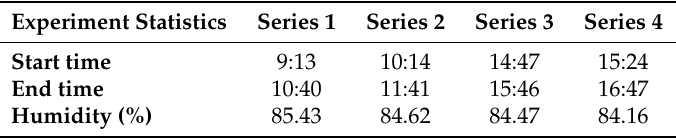
Table 2. Specifications of cutting experiments.